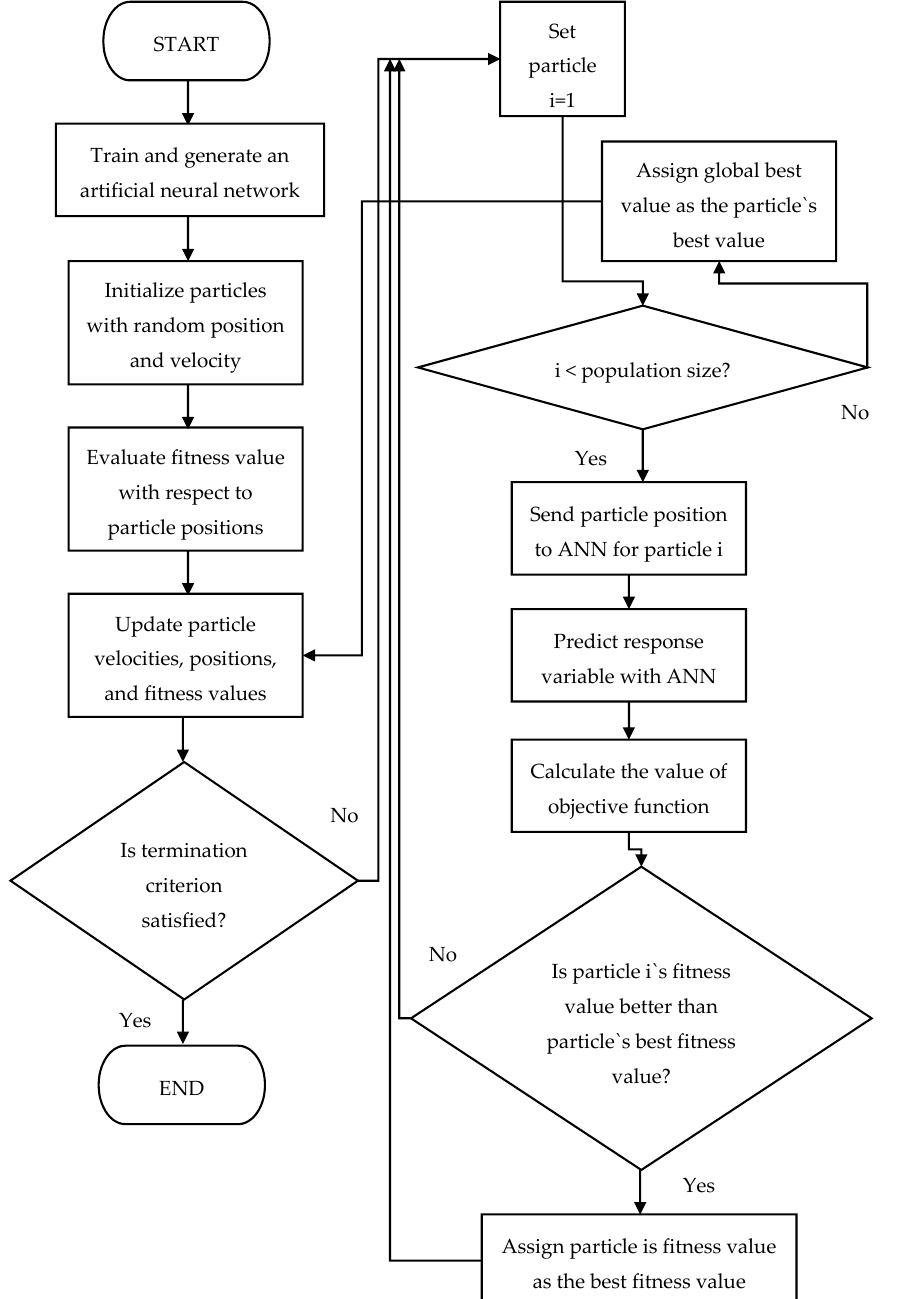
Figure 12. Flowchart of the integrated artificial neural network and particle swarm optimization algorithm.